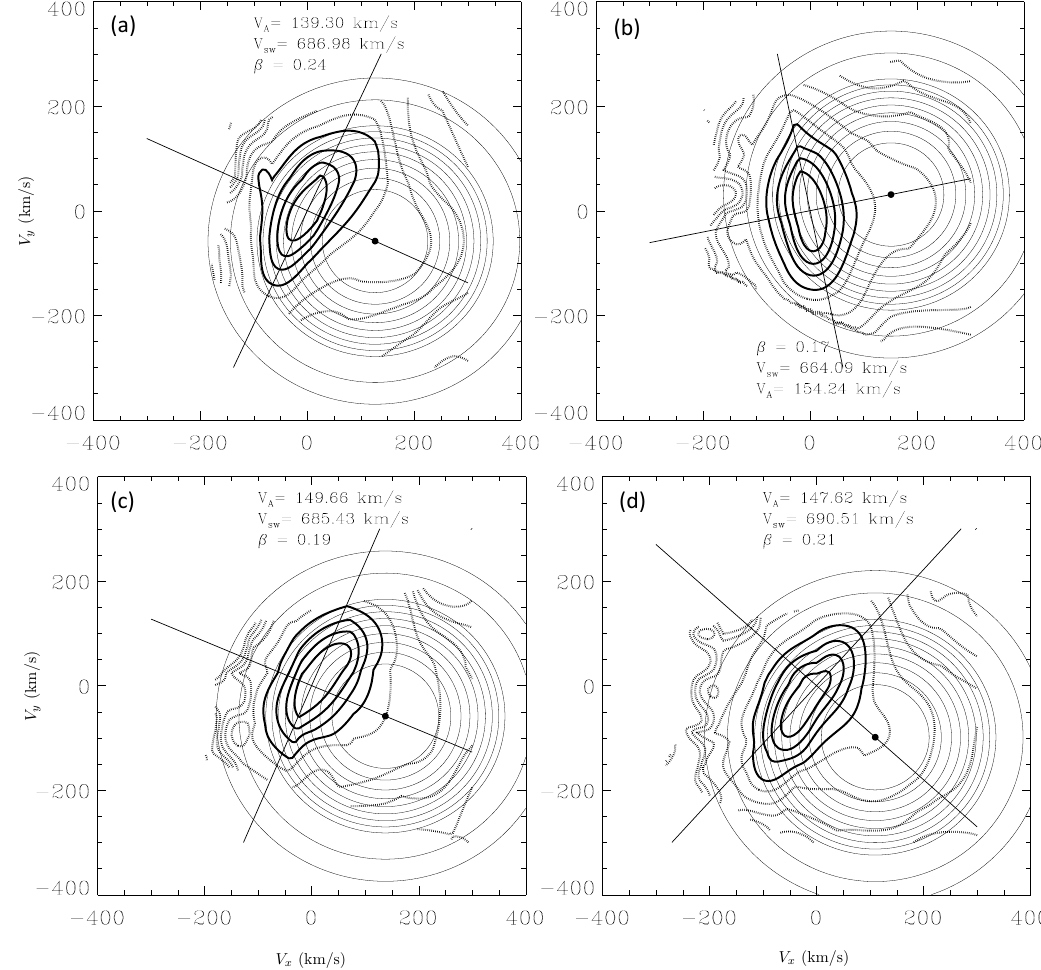
Fig. 1. Proton velocity distribution functions in fast solar wind, with the corresponding Alfv´en speed and wind speed indicated, together with the plasma beta. Dark continuous isodensity contours relate to 80, 60, 40, and 20% of the maximum, and the respective dotted contours to 10, 3.3, 1, 0.33, and 0.1%. The local magnetic field is the symmetry axis for these gyrotropic VDFs. The transverse straight line in the perpendiuclar direction to the field corresponds to a parallel speed of V k = 0, which defines the solar wind frame centered about in the maximum of the core protons. The location of the Alfv´en speed is indicated by a dark dot, which is the center of the circular diffusion lines along which protons pitch-angle scatter in oblique Alfv´en waves. The spacings of the concentric circles are determined by the variable spacings (radii) of the measured contour lines, and given by their intersections with the negative and positive V k axis, i.e. the magnetic field direction. The abrupt cutoffs of some contours are artifacts induced by the finite resolution of the plasma instrument in velocity space. The measurements of the VDFs were made on 14 April 1976 at the times (hours:minutes:seconds): (a) 22:43:08, (b) 23:07:26, (c) 23:20:56, and (d) 23:42:32. All data correspond to a heliocentric distance of